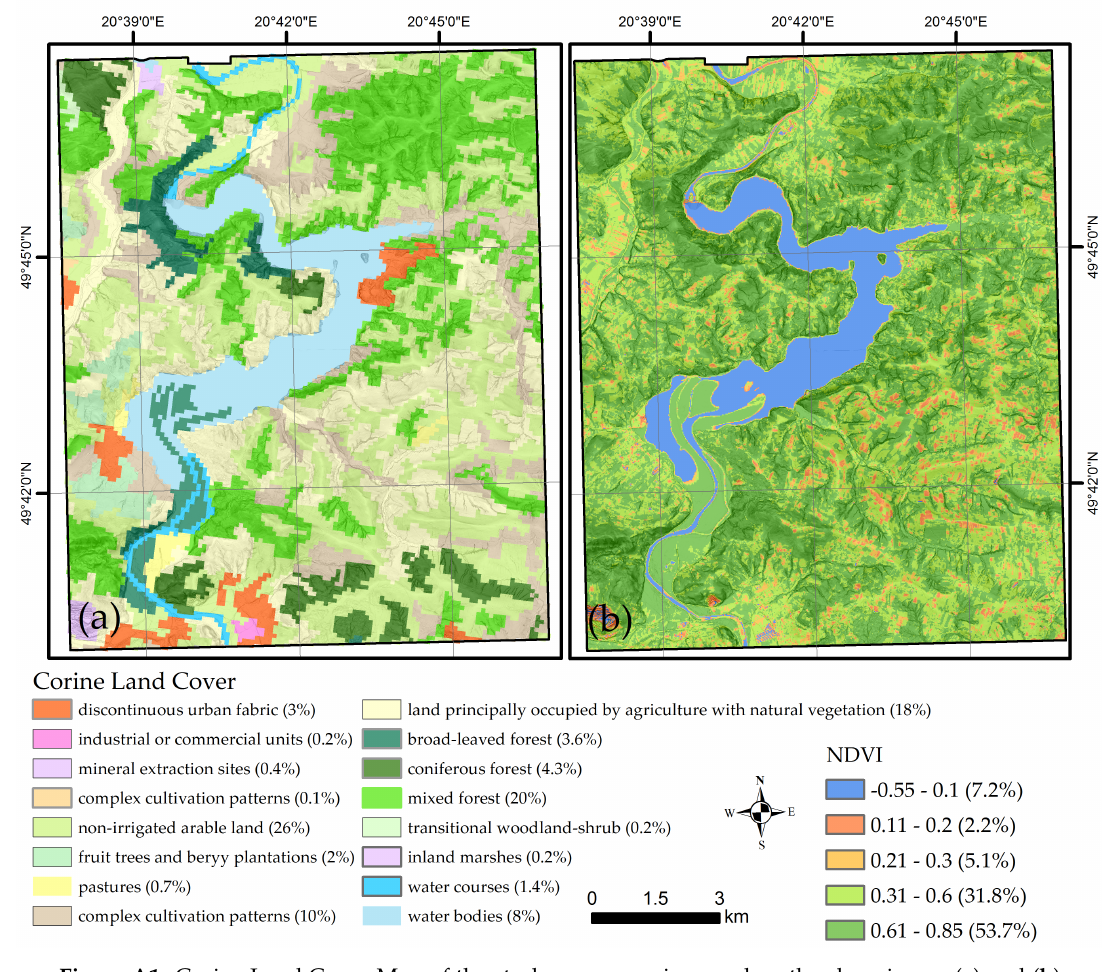
Figure A1. Corine Land Cover Map of the study area superimposed on the slope image ( a ) and ( b ) Normalized Di ff erence Vegetation Index (NDVI)